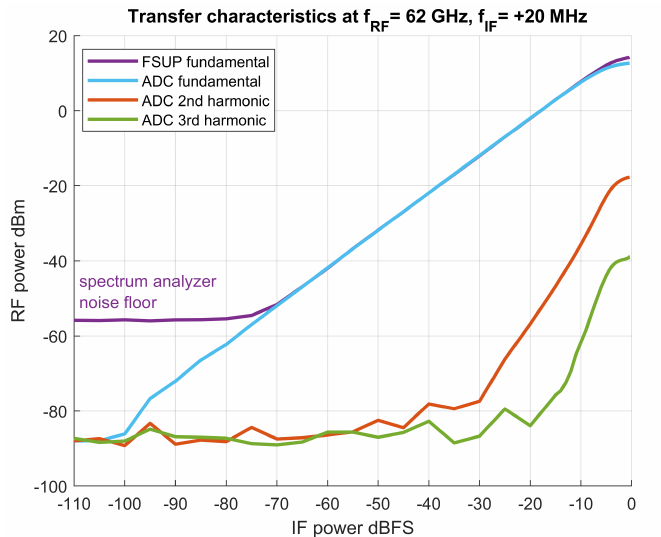
Figure 7. Overall measured transfer characteristics of the transmitter–observation receiver